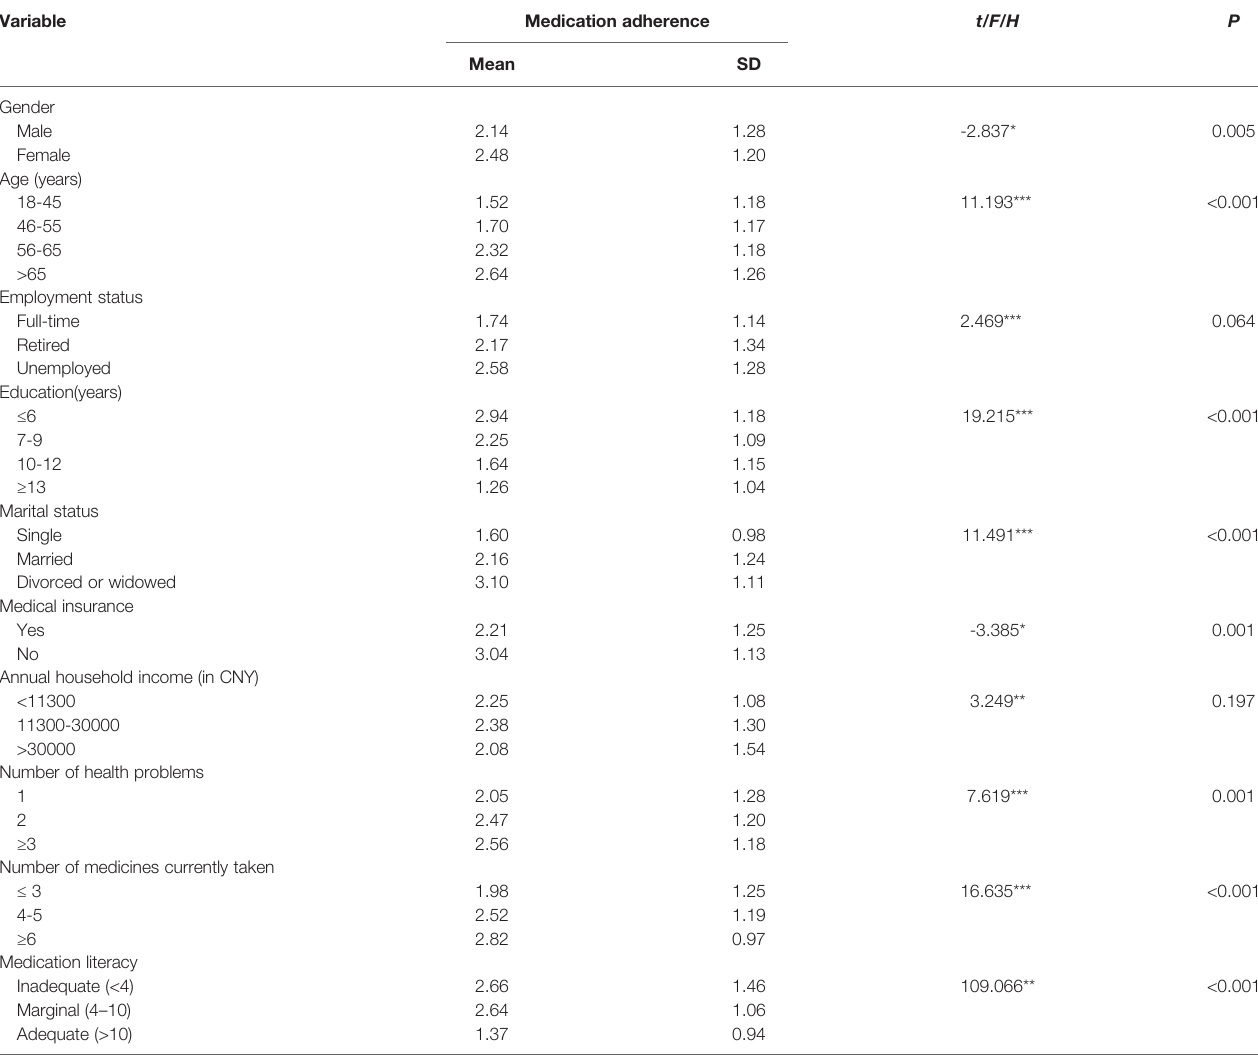
TABLE 4 | Results of univariate analysis of determinants of medication adherence for inpatients with coronary heart disease Changsha, Hunan, China (N=470). Variable Medication